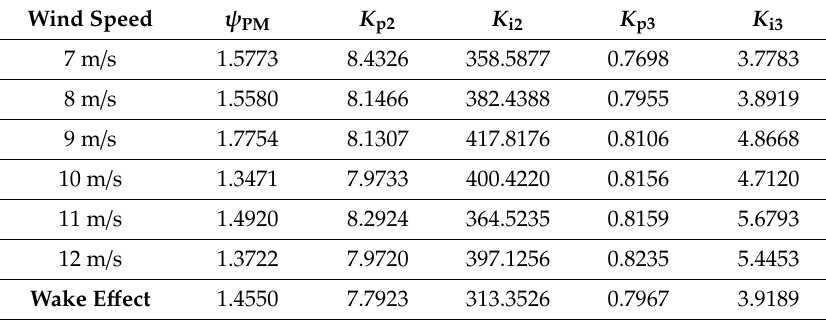
Table 6. Parameter identification results 100%